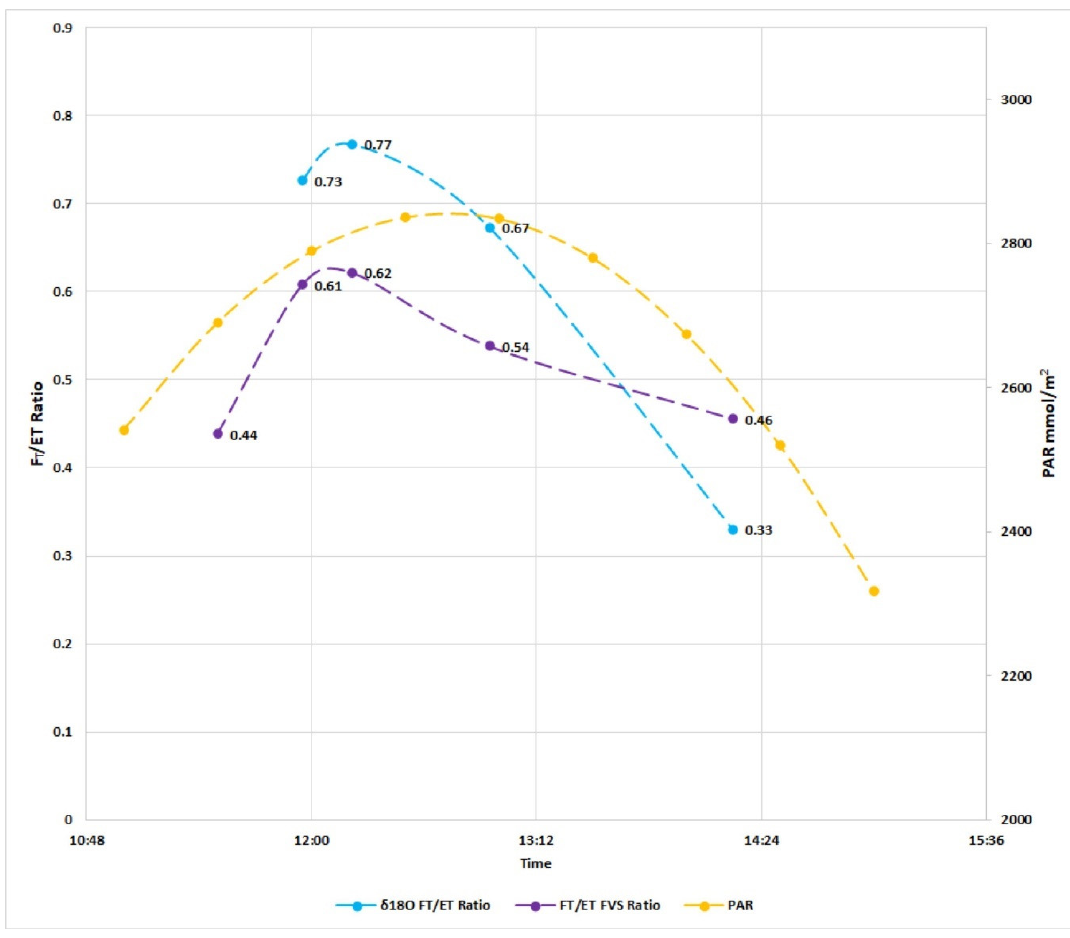
Figure 6. Comparison between IMB δ 18 O and Flux Variance Similarity (FVS) F T /ET.